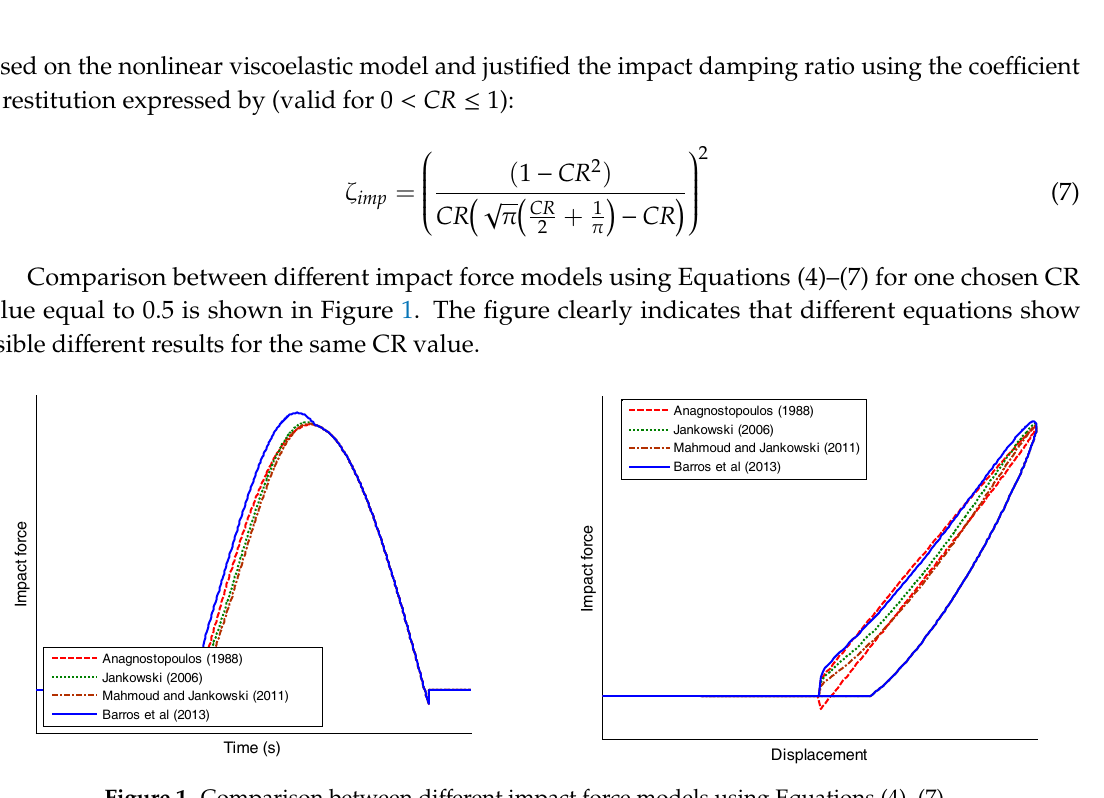
Figure 1. Comparison between different impact force models using Equations (4–7).